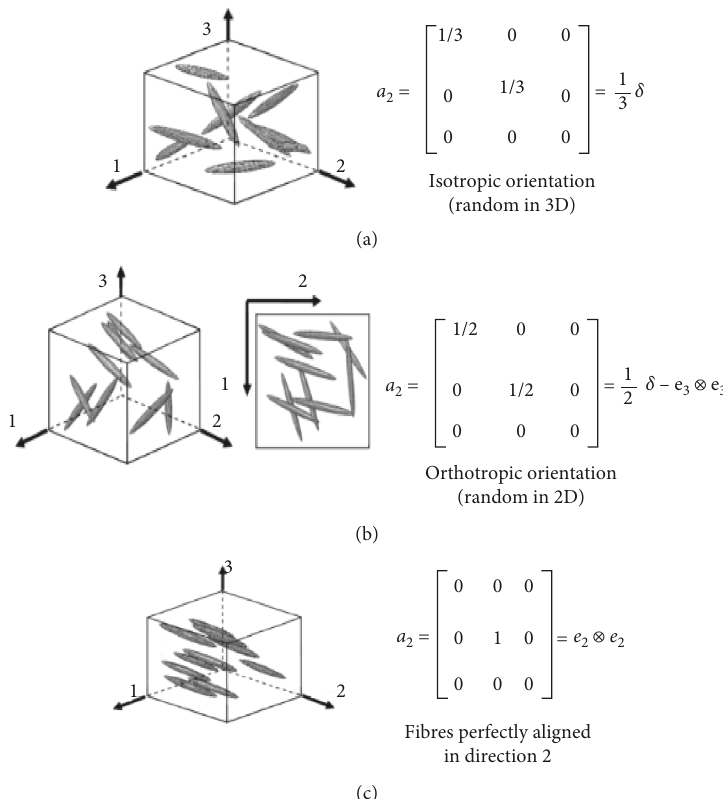
Figure 7: Examples of orientation: (a) random orientation in 3D, (b) random orientation in 2D, and (c) aligned orientation